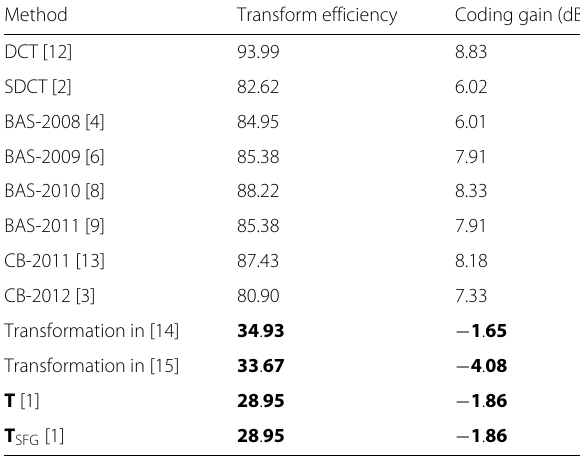
Table 1 Transform coding